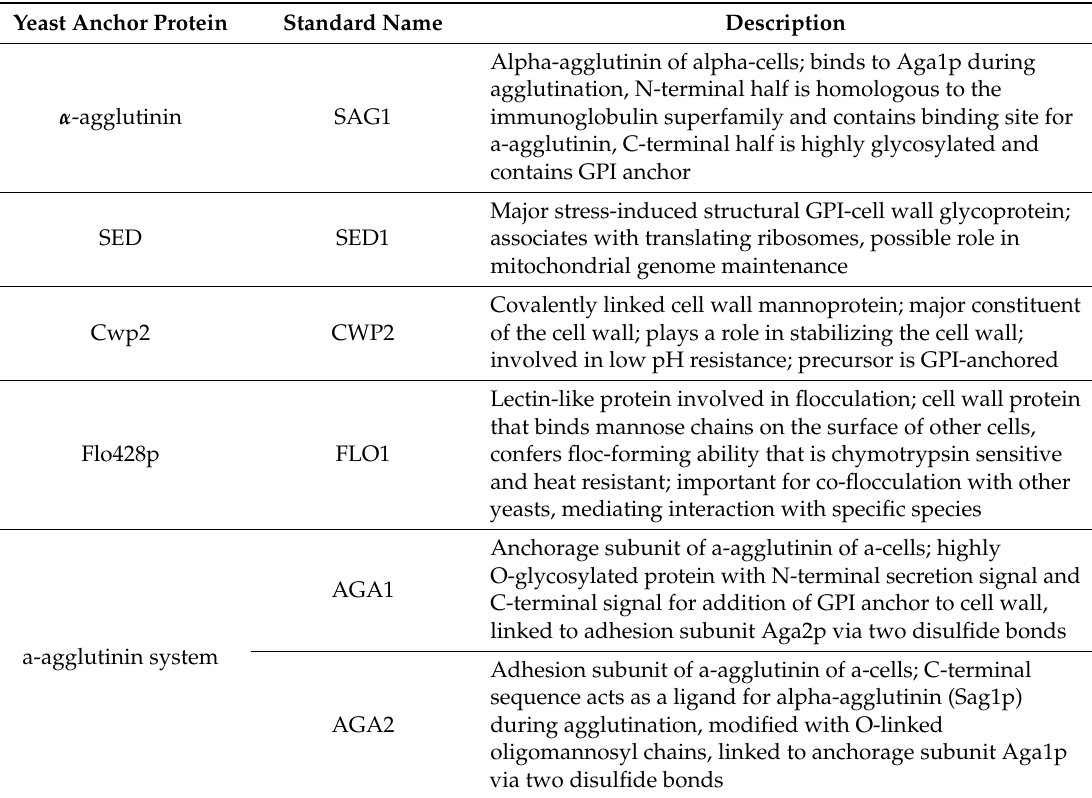
Table 2. Typical yeast anchor proteins used for surface